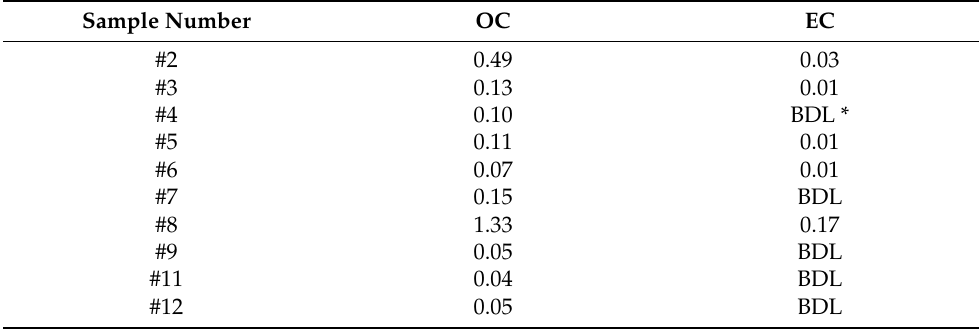
Table 6. Organic carbon (OC) and elemental carbon (EC) concentrations measured in samples collected during the Araon cruise in 2018 (unit: µ g/m 3